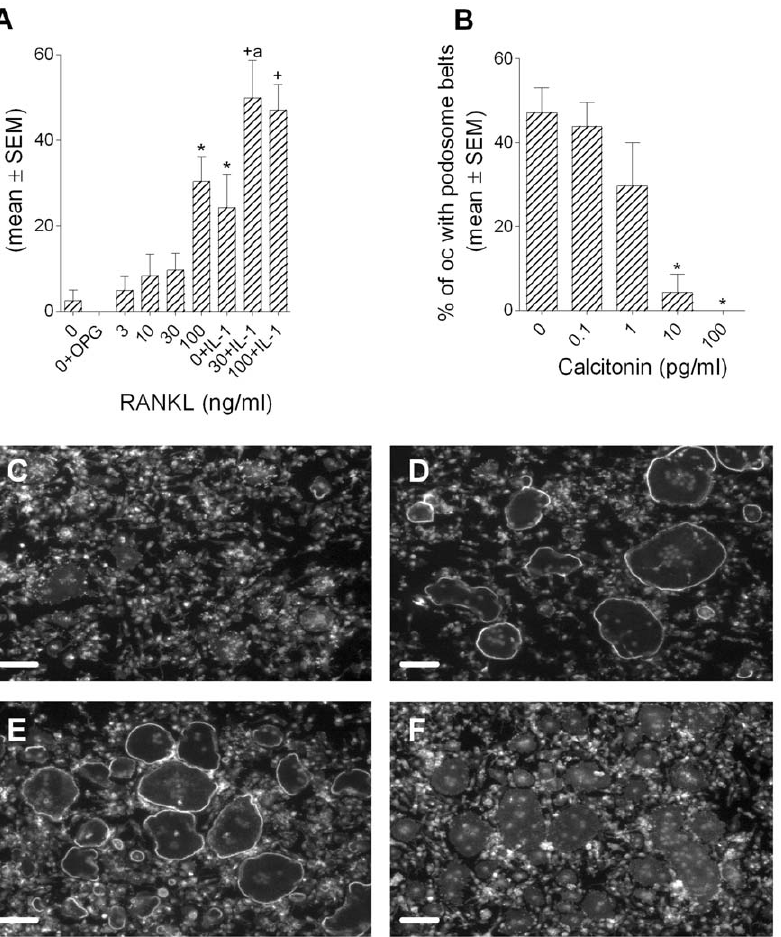
Figure 2. Podosome belt formation is regulated in a manner that parallels regulation of bone resorption. Bone marrow-derived osteoclasts were sedimented in MEM/FCS onto glass coverslips. After 20minutes, the coverslips were washed and incubated for 5 hours in MEM/FCS in M-CSF (50 ng/ml) plus the agents shown (A), or MEM/FCS in M-CSF (50 ng/ml), RANKL (30 ng/ml) and IL-1 a (10 ng/ml) with/without salmon calcitonin (B). A: OPG: 500 ng/ml; IL-1 a : 10 ng/ml. *p , 0.05 versus 0; + p , 0.05 versus 0 + IL-1 m , both ANOVA plus Dunnett’s post-test; a: p , 0.05 versus RANKL (30 ng/ml), ANOVA + Bonferroni post-test. n=10 per variable. C-F: photomicrographs of phalloidin/DAPI preparations of cultures after incubation as above in: C: 0; D: RANKL (30 ng/ml); E: RANKL (30 ng/ml) + IL-1 a ; F: calcitonin (100 pg/ml). Scale bars =100 m